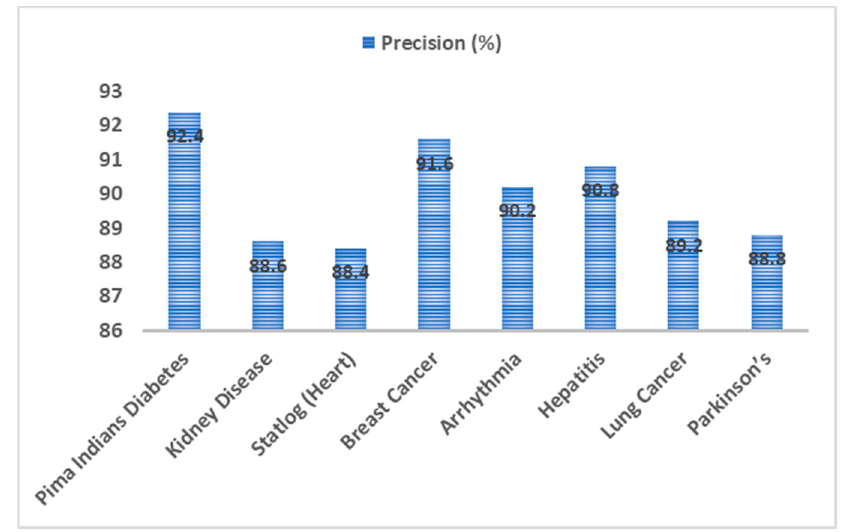
Figure 13. Precision analysis of EAGA-MLP model over different chronic disease datasets.